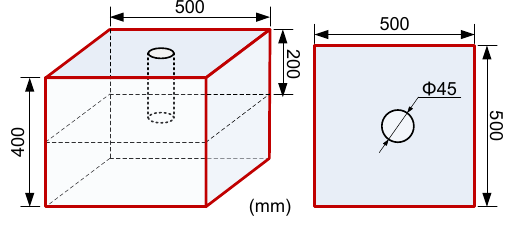
Figure 5. Size diagram of concrete sample.